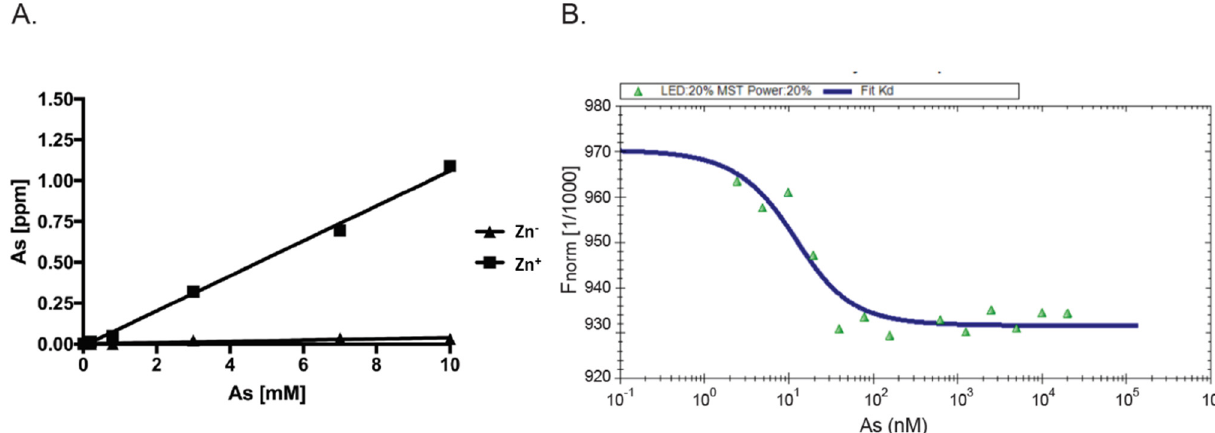
Figure 2. Dependence on zinc and MST measured affinity. ( A ) The presence of arsenite bound to AIRAP was determined by ICP-OES. Recombinant AIRAP was incubated in the presence (Zn + ) or absence (Zn − ) of zinc, prior to arsenite exposure. Bound material was extensively washed and arsenite content determined. ( B ) Recombinant AIRAP (1 µ M) was incubated with a range of arsenite dilutions as indicated, and intrinsic fluorescence was measured by MST. Analysis revealed Kd values of 7 nM ± 0.87 nM.